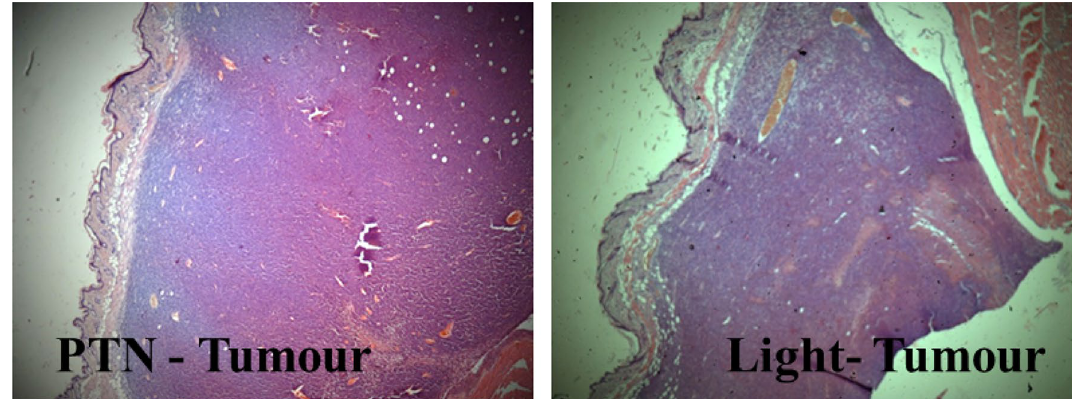
Figure 9. Control tumours treated with PTN or light alone. Tumours treated twice with PTN and non- illuminated (PTN-Tumour) or illuminated twice previous application of vehicle (Light-Tumour); mice were sacrificed and tissues excised 24 h after the last dose. Sections were photographed using the × 4